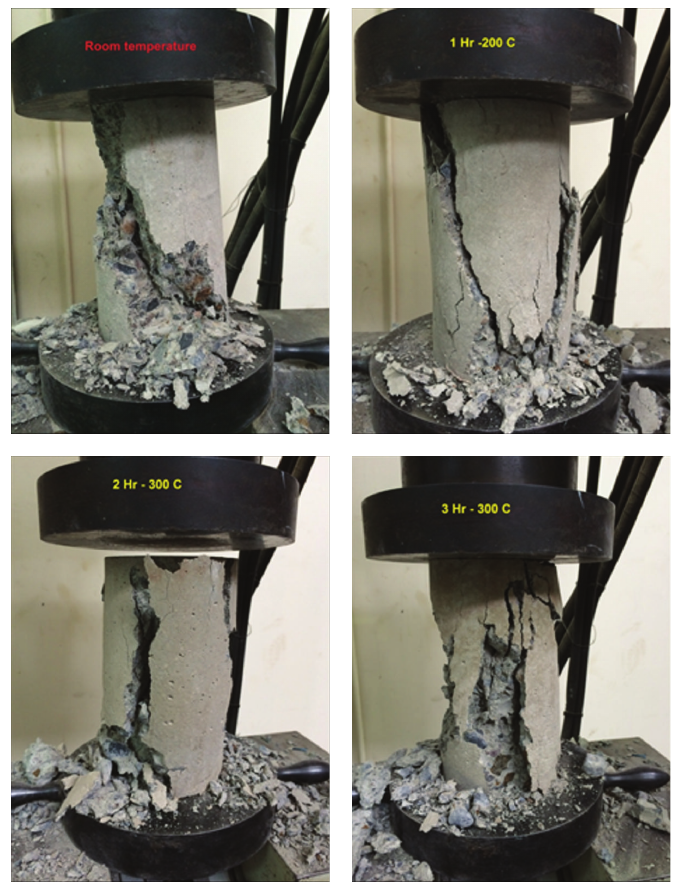
Figure 6: Failure of the unconfined specimens.